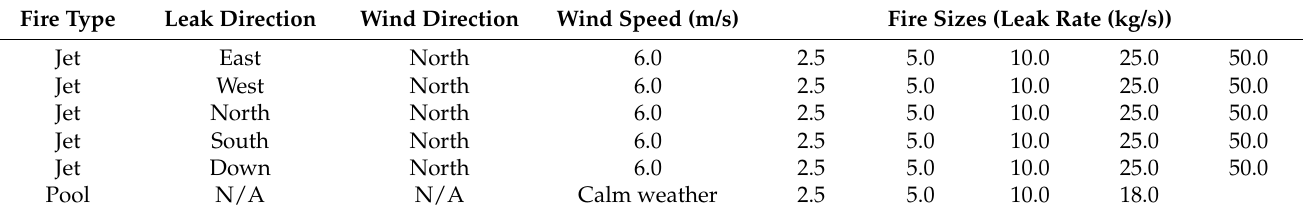
Table 5. Fire scenarios simulated for Leak